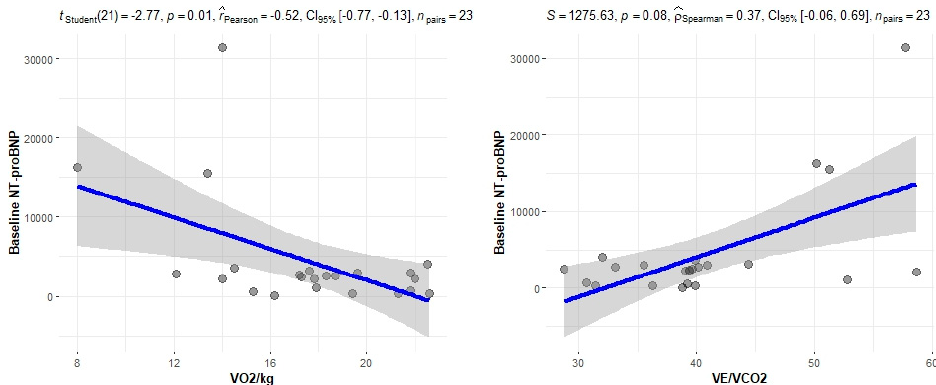
Figure 2. Correlation between CPET parameters and NT-proBNP.